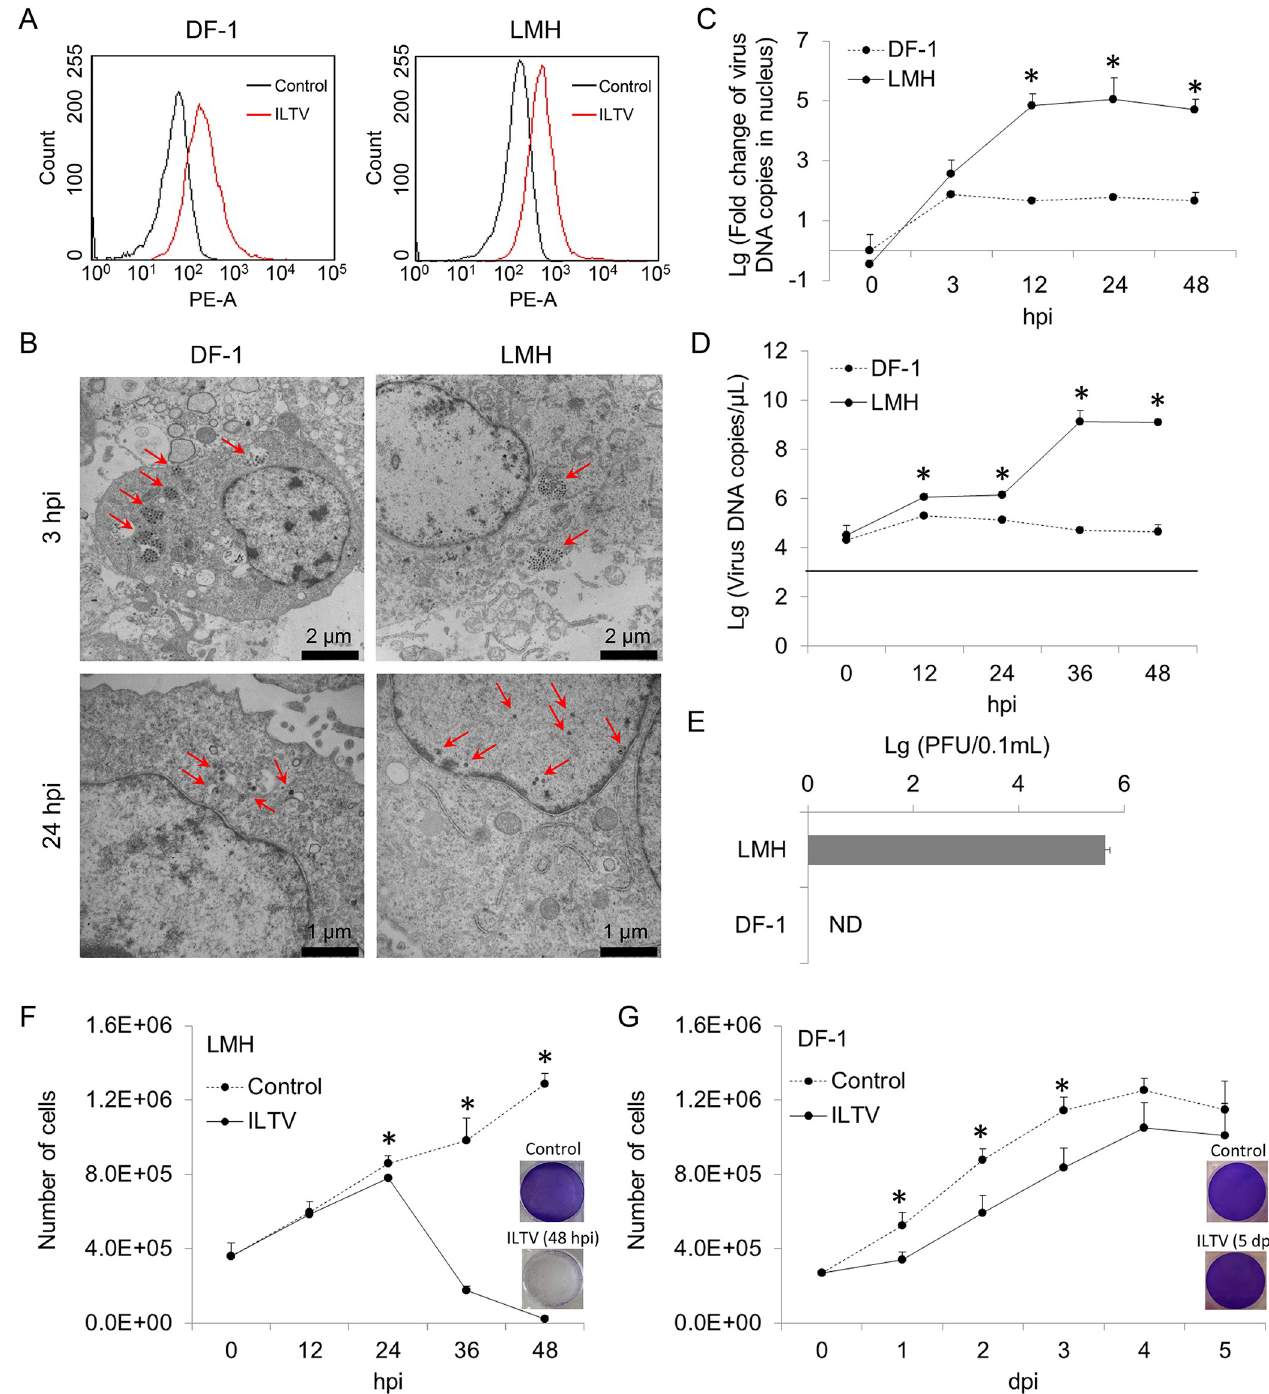
Fig 1. Biological characterization of ILTV infection in LMH cells and DF-1 cells. (A) Flow cytometry diagram of the membrane fusion showing in LMH and DF-1 cells infected with ILTV (MOI 1) at 3 hours post infection (hpi). (B) Transmission electron microscopy images of ILTV-infected LMH and DF-1 cells (MOI 5) at 3 and 24 hpi. Representative images are shown for each condition. The arrows show viral particle locations within the cell. (C) The numbers of viral genome copies in cell nuclei of DF-1 and LMH cells were determined by ILTV-specific qPCR (MOI 0.1). (D and E) The replication of ILTV in DF-1 and LMH cells was determined by ILTV specific absolute RT-qPCR (D) and plaque assays (E), respectively (MOI 0.1). The dotted line in D indicates detect limit. (F and G) The growth curves of LMH (F) and DF-1 (G) cells after ILTV infection (MOI 1). The number of adherent cells that were negative for trypan blue staining was counted. The cytopathic effect of ILTV infection on cells was visualized by crystal violet staining. The results in C to G are presented as the mean ± SD, n = 3. Asterisks indicate statistical difference ( p < 0.05).